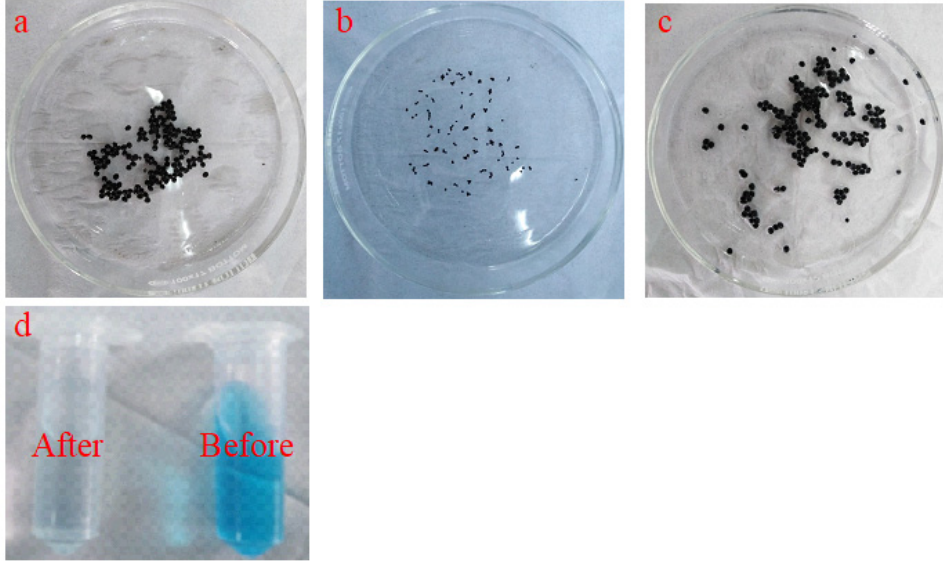
Figure 2. Photographic images of ( a ) as prepared GO@CS beads, ( b ) GO@CS beads after air drying, ( c ) GO@CS beads after use in the treatment process, and ( d ) the dye solution before and after the decontamination